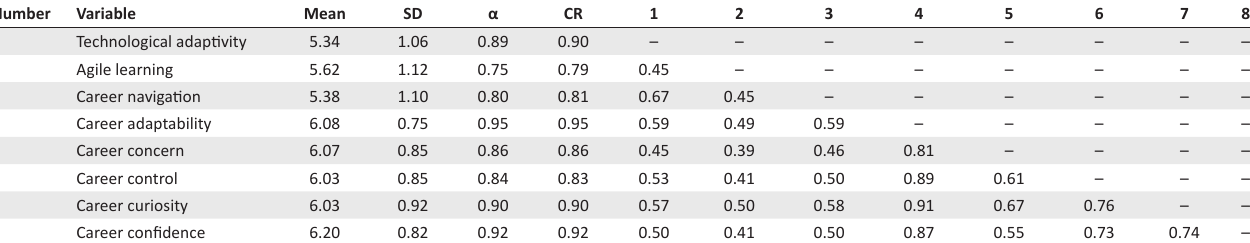
TABLE 1: Descriptive statistics, internal consistency reliability, and bivariate correlations ( N = 177).